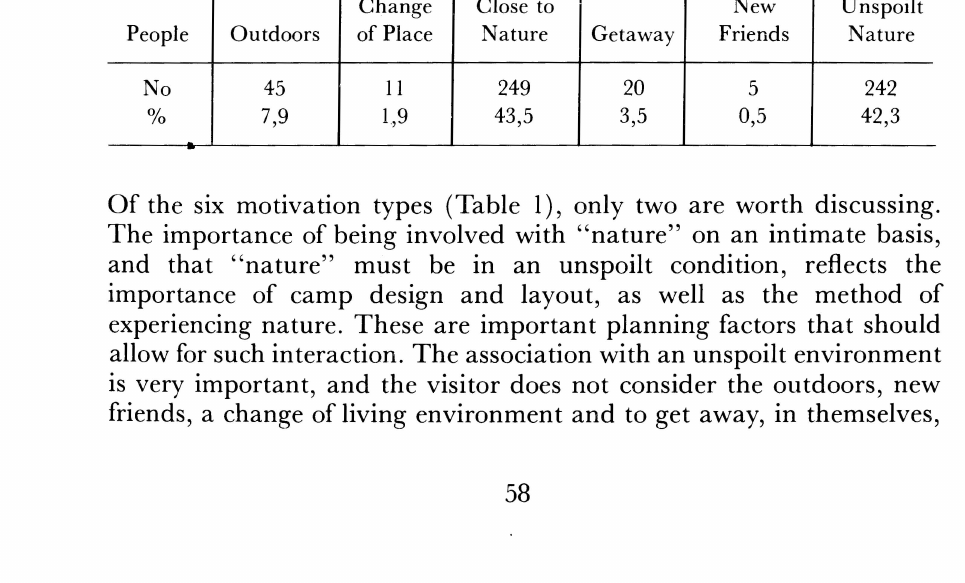
Motivation factors for outdoor